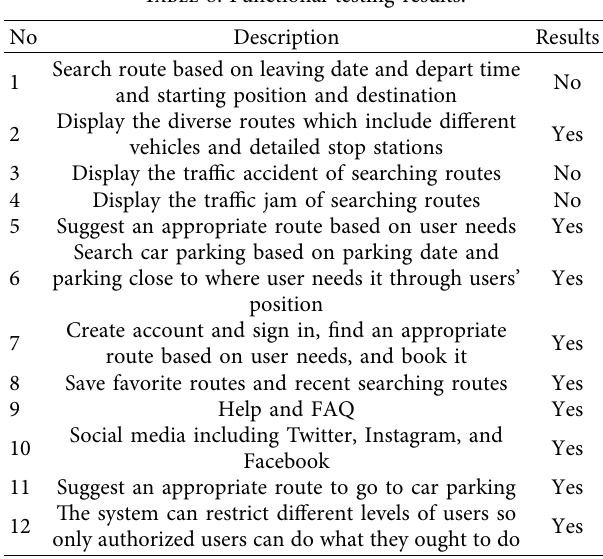
Table 8: Functional testing